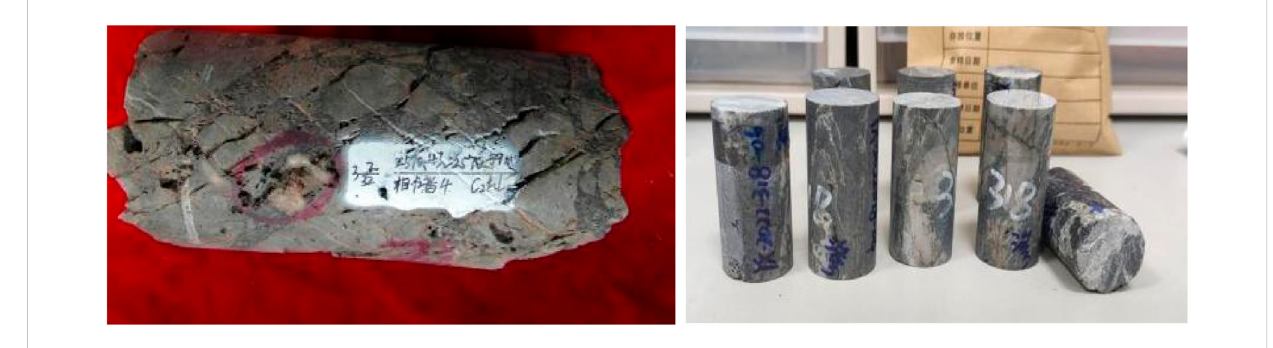
FIGURE 1 Injection production well core and cylindrical core